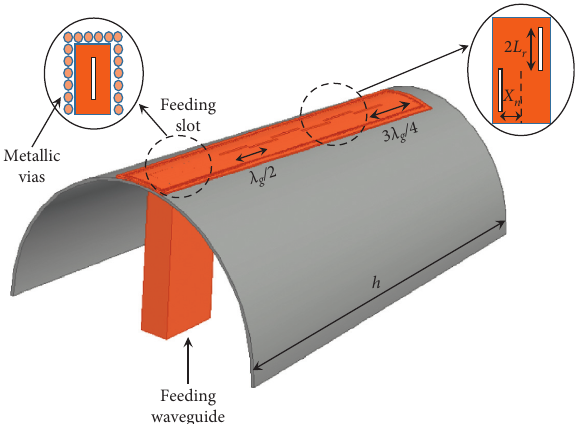
Figure 6: Configuration of hollow nose-cone conformal SIW slot array antenna. Table 1: Design parameters of nose-cone and cylindrical conformal SIW slot array antennas. Nose-cone parameters